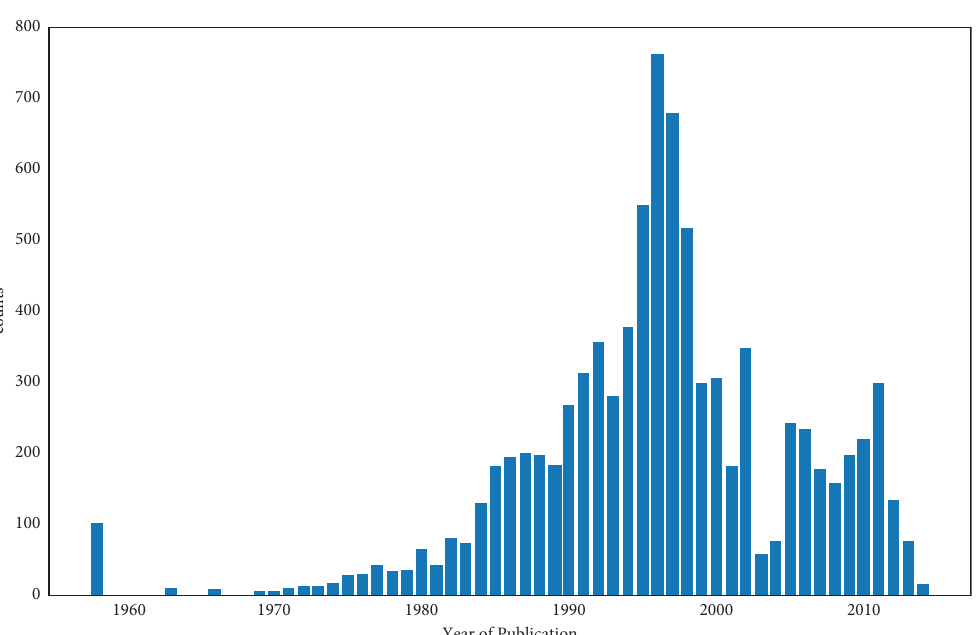
Figure 4: Book distribution along publication